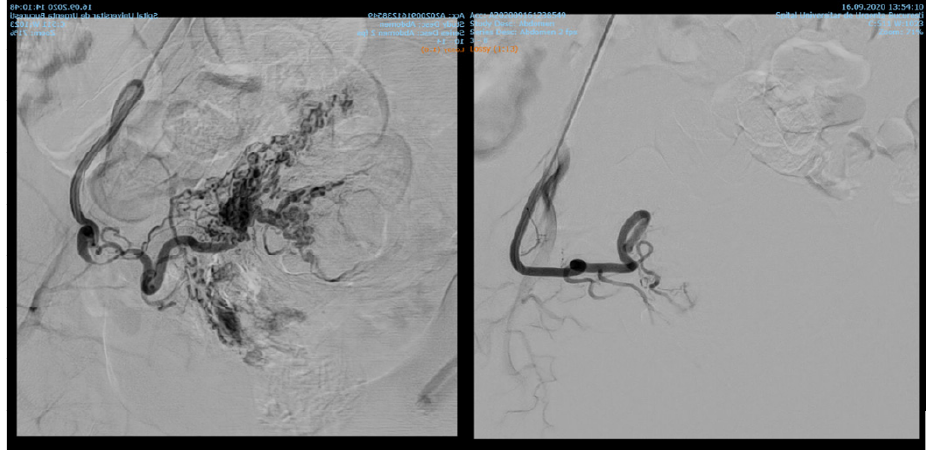
Figure 4. Pelvic artery embolization for cervical ectopic pregnancy.